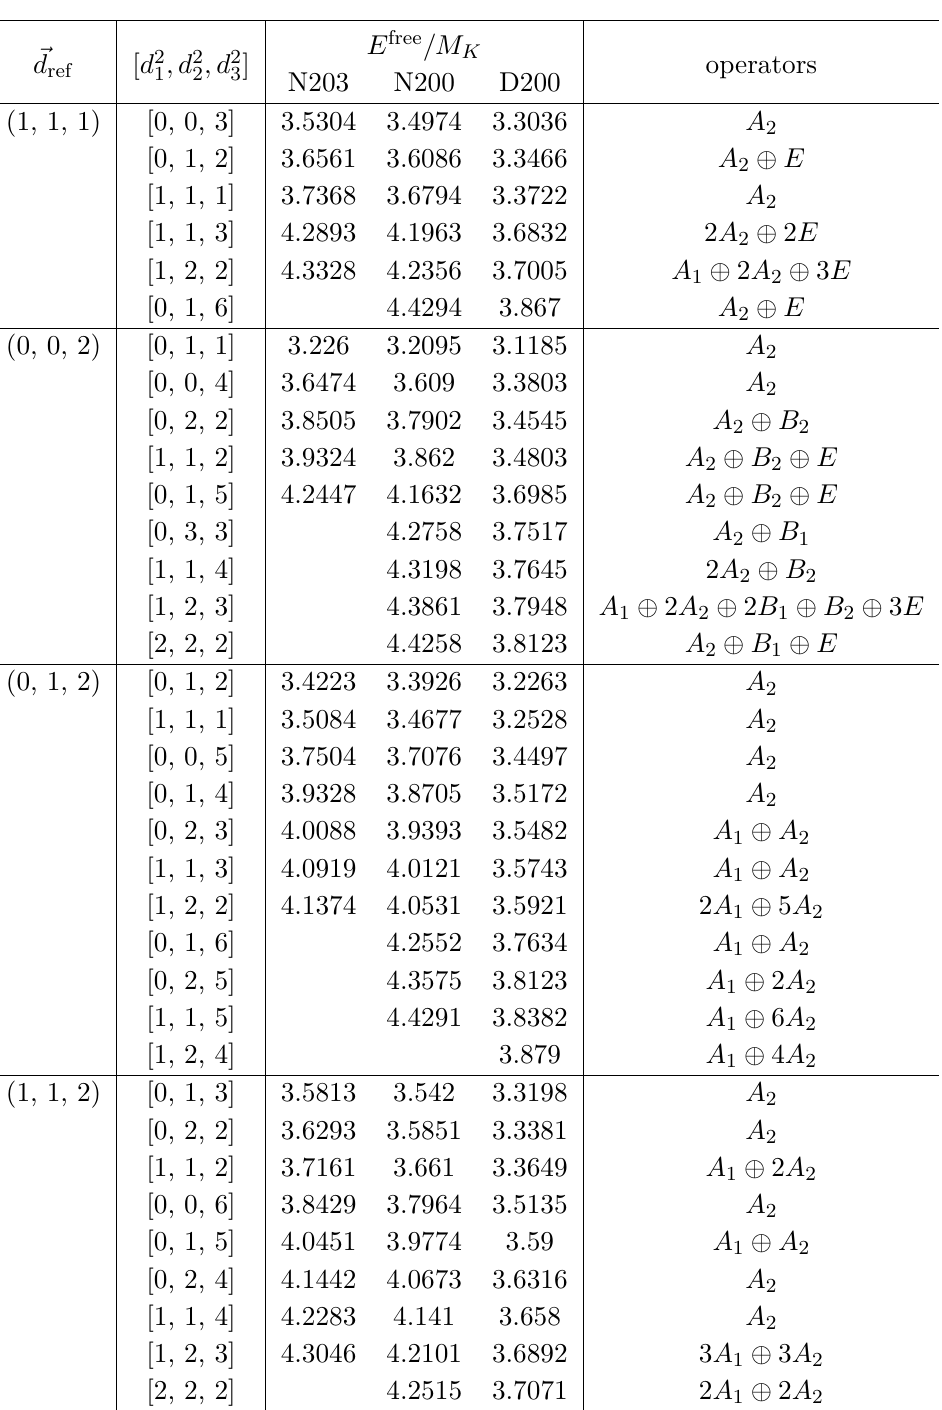
Table 25. Same as table 21 except for the three-kaons operators with 3 ≤ ~d 2